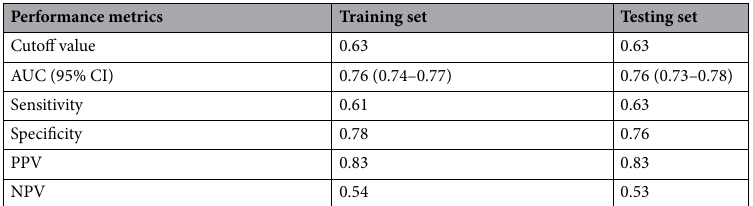
Table 4. Performance of the simplified risk prediction model in the training and testing set. AUC, area under the receiver operating characteristic curve; CI, confidence interval; PPV, positive predictive value; NPV, negative predictive